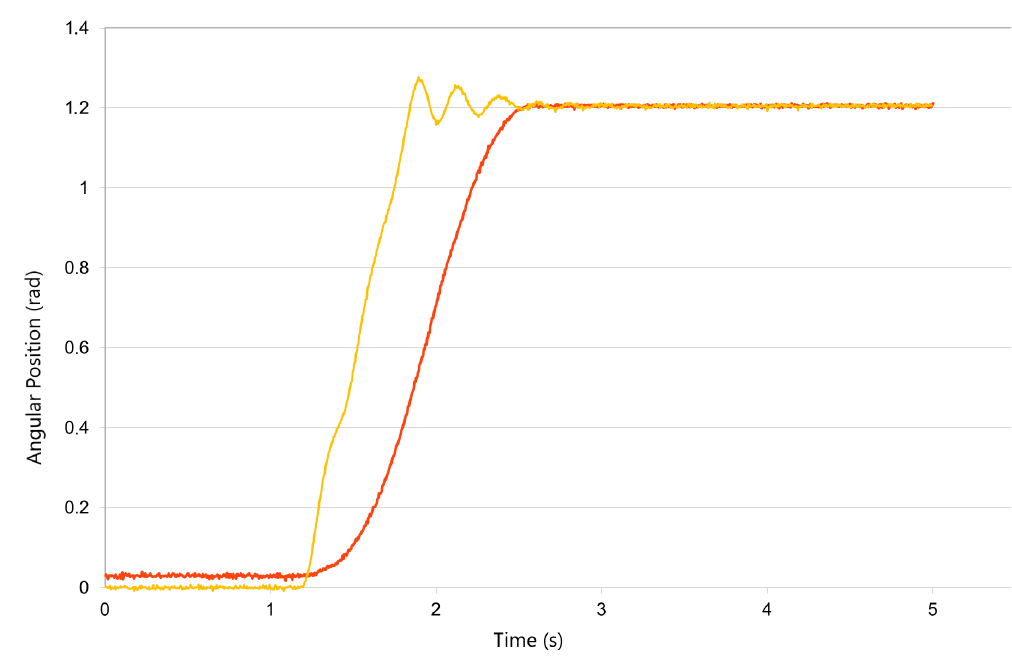
Figure 18. Comparison between References.